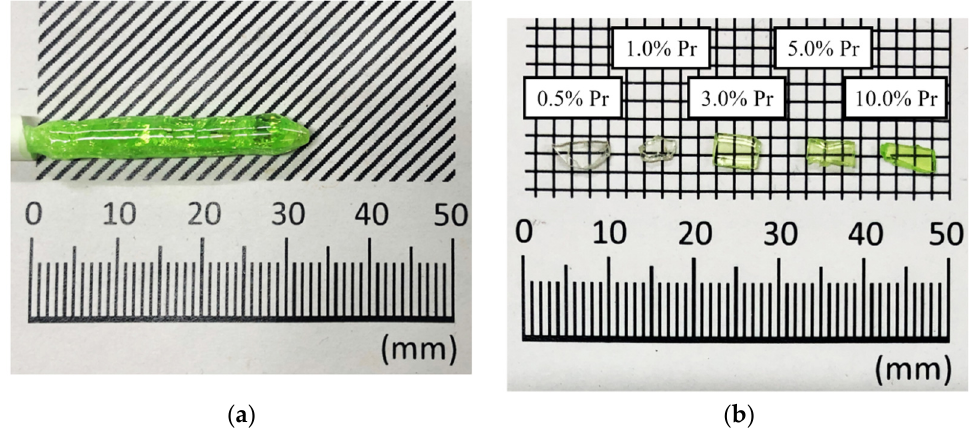
Figure 1. Photographs of Pr-doped LaPS single crystal samples: ( a ) as-grown (10.0 % Pr-doped); ( b ) after being cut and polished.